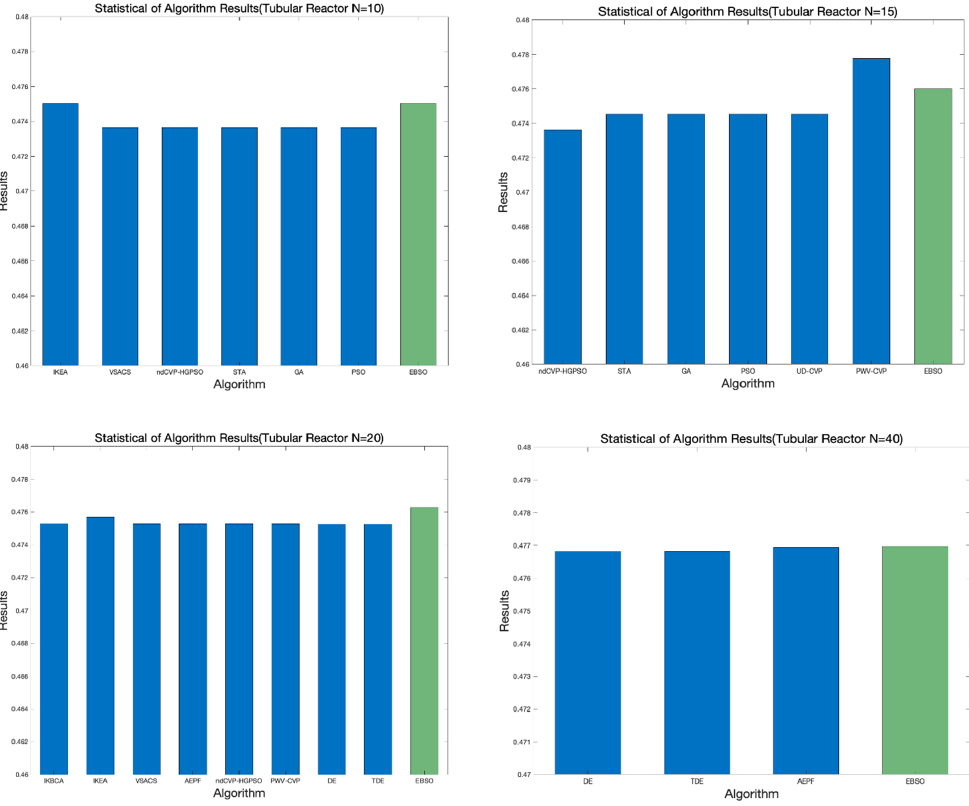
Figure 33. Statistical charts of algorithm